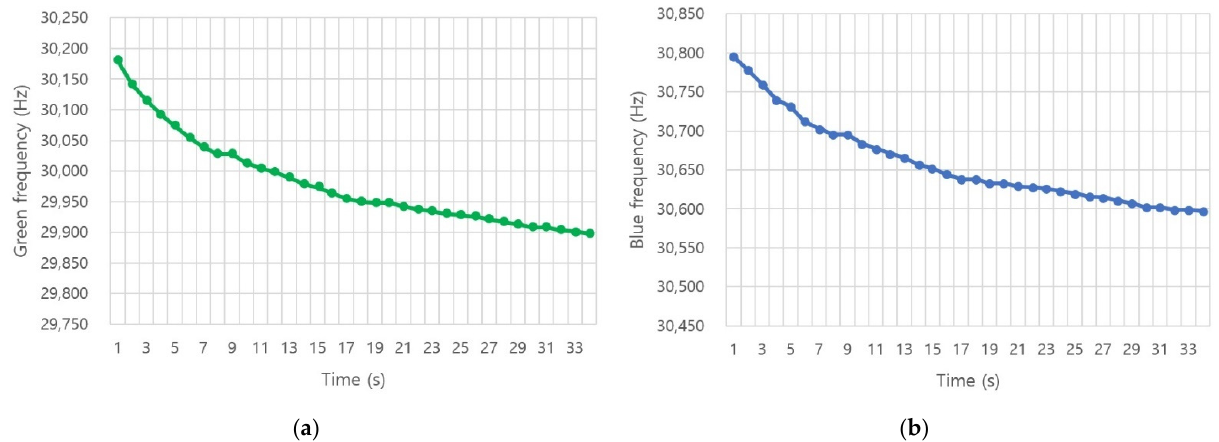
Figure 8. Decreasing in intensity of LED light over time due to LED aging: ( a ) green light output frequency; ( b ) blue light output frequency.